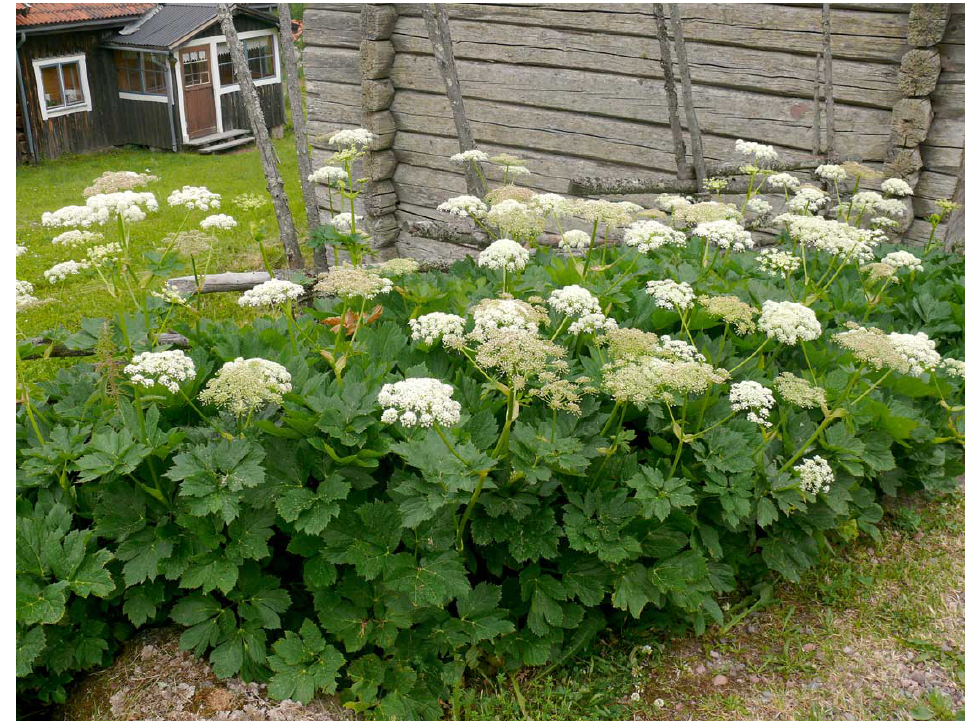
Figure 1. Peucedanum ostruthium in Orsa parish, Dalecarlia (Photo Arne Holmer).